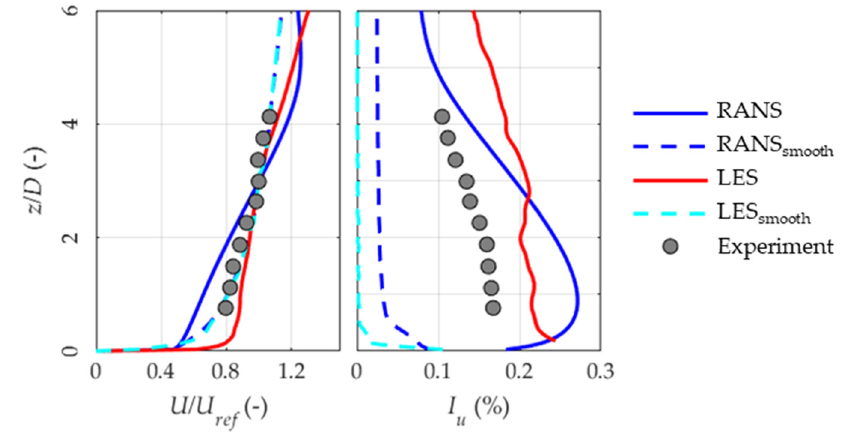
Figure 5. Inflow wind speed and its standard deviation, as predicted by the RANS and LES models, compared to the experimental measurements.